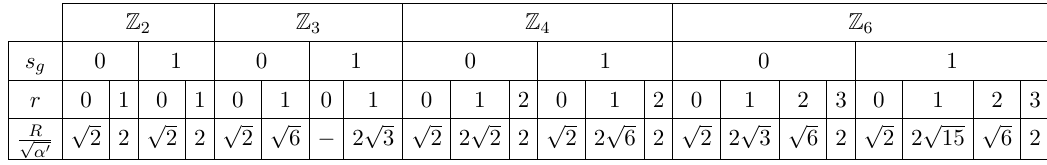
Table 2. Tachyon bounds on the radius of S 1 for Z N class I models. In Z 2 , Z 4 and Z 6 , s 3 = 1 , while s 3 = (1 + s g ) mod 2 in Z 3